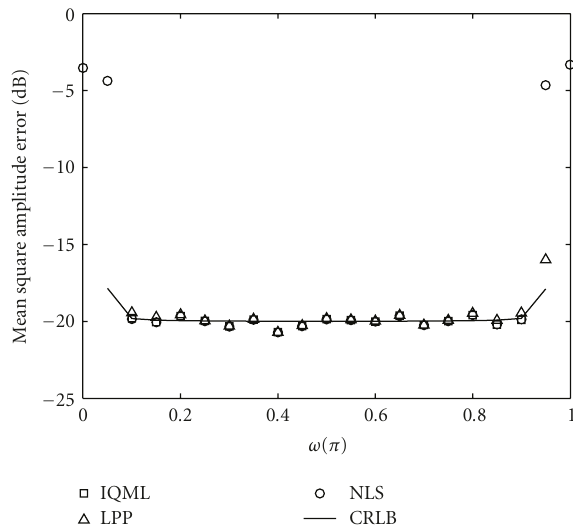
Figure 12: MSE for φ of single real sinusoid with random φ . Figure 13: MSE for A of single real sinusoid at SNR =